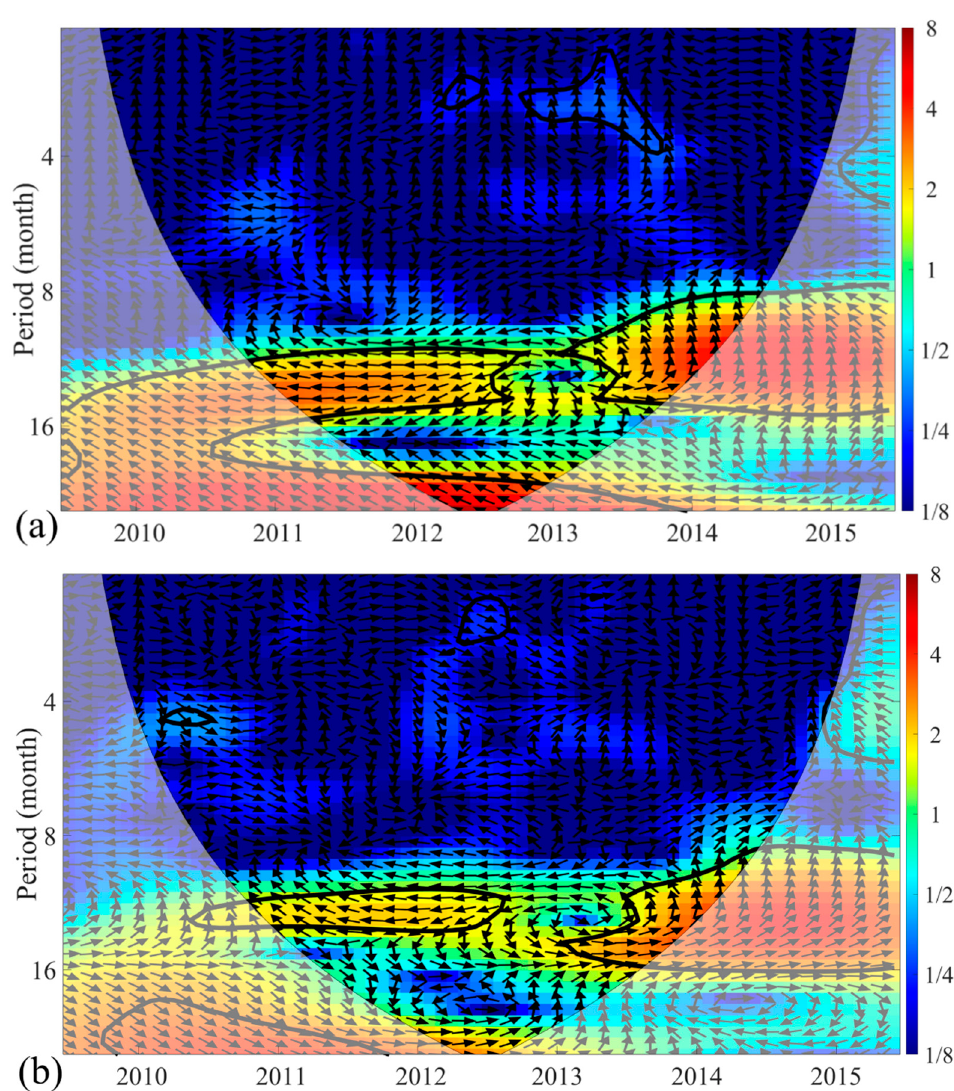
Figure 16. The cross-wavelet transform (XWT) between the PDSI and TVDI time series in the middle and lower reaches of the Yangtze River from 2010 to 2015. The abscissa and ordinate represent the year and period (month), respectively, and the color bar on the right is the wavelet energy. The arrows indicate the relative phase relationship. ( a ) The XWT of the PDSI and TVDI in rain-fed arable land. ( b ) The XWT of the PDSI and TVDI in irrigated arable land.